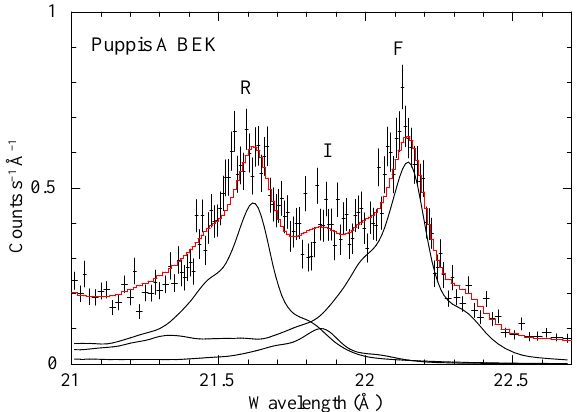
Figure 3: RGS spectrum zooming into O VII He α from the BEK in Puppis A. The positions of the res- onance (21.6˚A), the intercombination (21.8˚A), and the forbidden line (22.1˚A) are